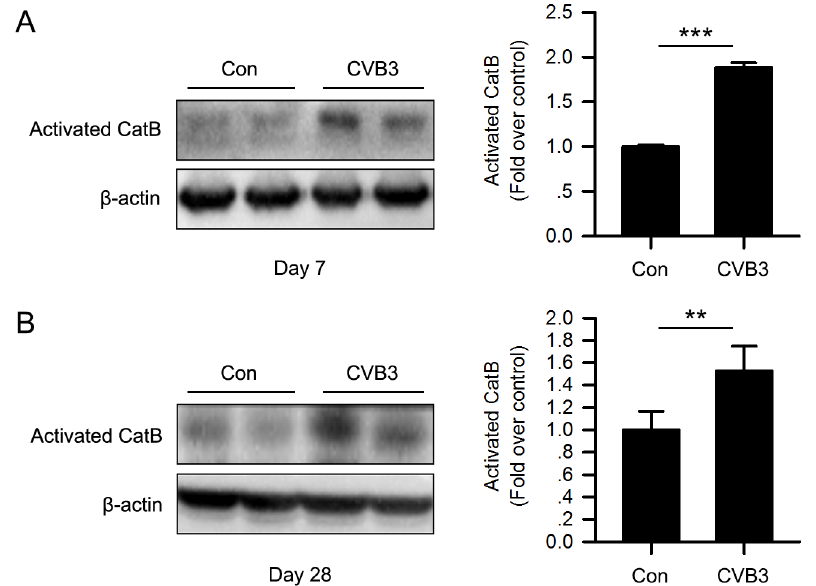
Fig 2. CatB was activated in hearts of CVB3-induced VMC mice. Hearts were harvested on day 7 and day 28 after virus inoculation. Western blot analysis showed that cardiac expression of activated CatB was significantly enhanced in the CVB3 group on day 7 (A) and day 28 (B) post-infection compared with the control group. (Con: control group; CVB3: coxsackievirus B3 group; Con: n = 10; CVB3: n = 10; (cid:3)(cid:3) P < 0.01 vs . Con; (cid:3)(cid:3)(cid:3) P < 0.001 vs .